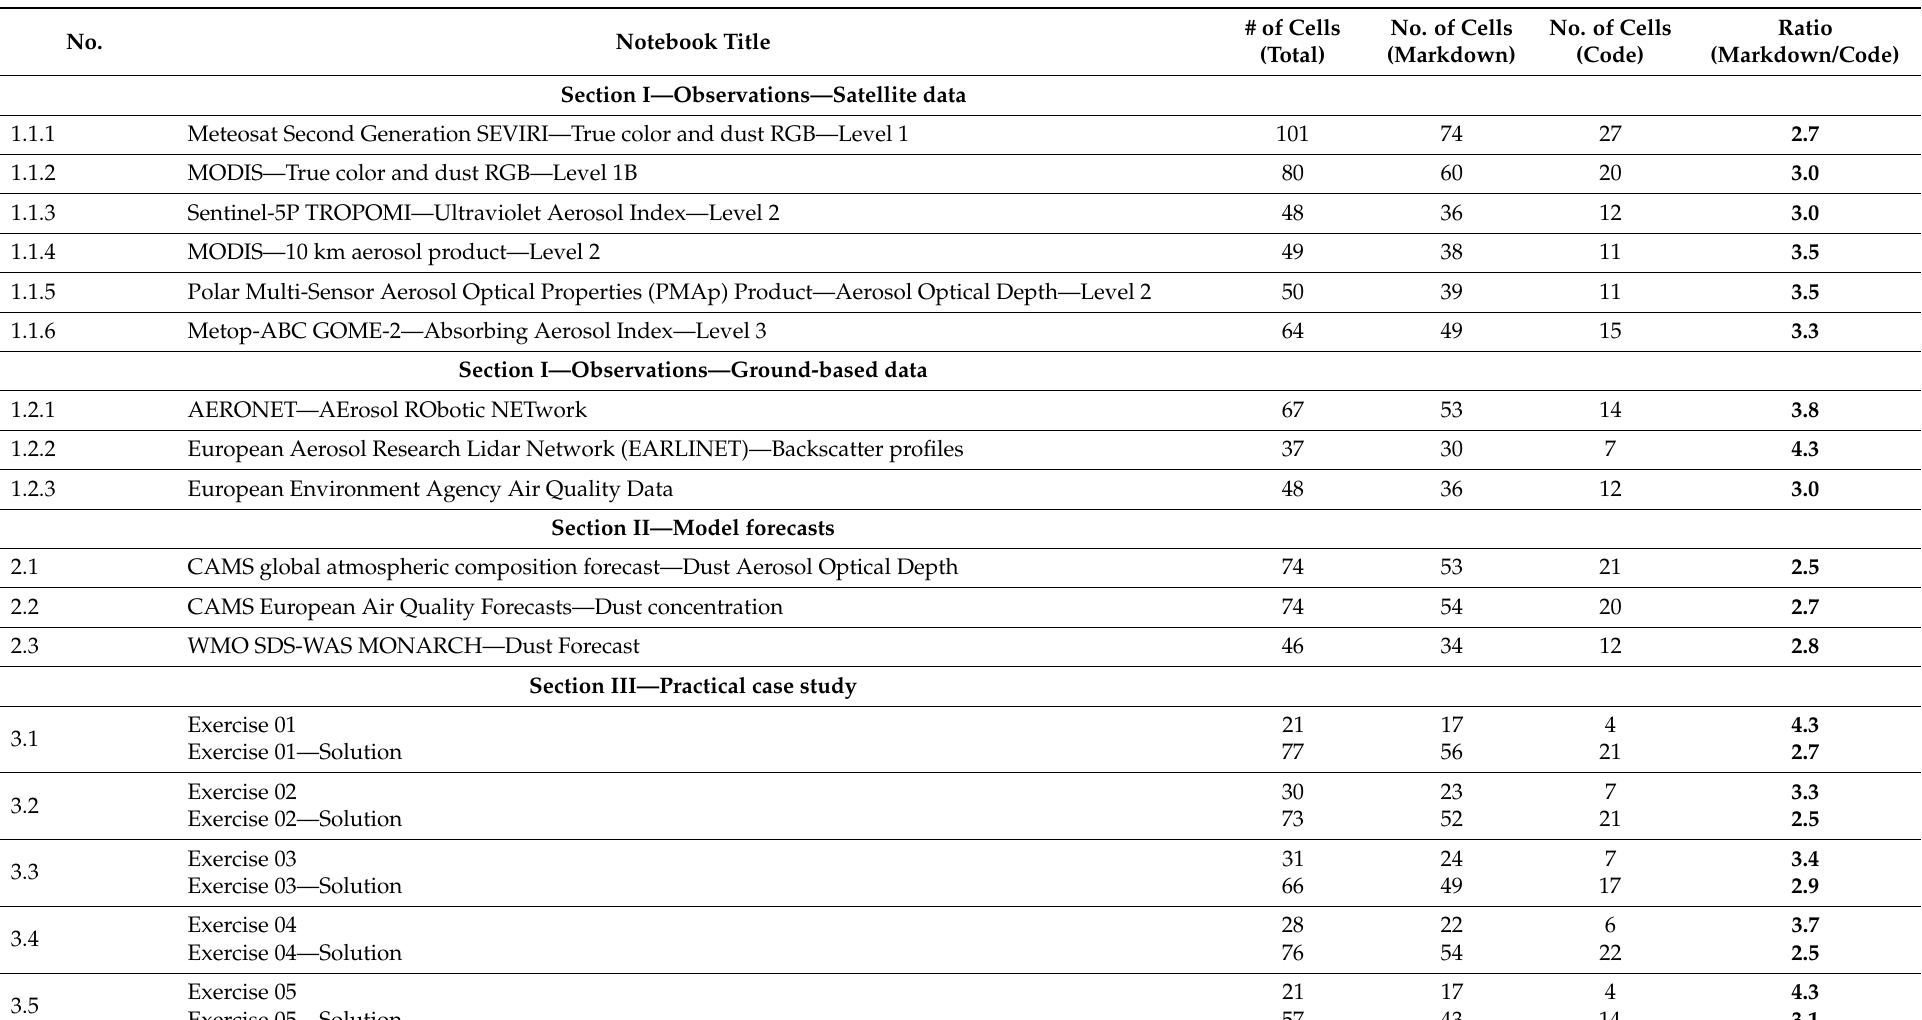
Table A6. Overview of notebooks that are part of the thematic module on dust monitoring and forecasting and for each notebook the number of cells in total, number of markdown cells, number of code cells and the markdown/code ratio is